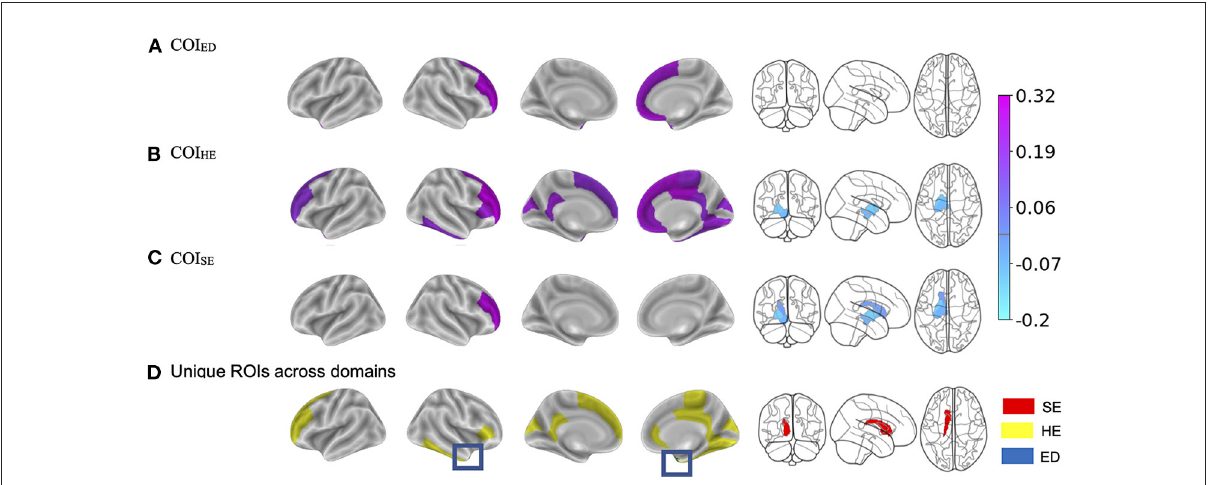
FIGURE4 (A–C) Visualization of the brain regions that showed significant two-way interactions with each Child Opportunity Index (COI) domain of interest, controlling for the other two COI domains of no interest, income-to-needs, sex, puberty, race, ethnicity, and time (e.g., visit number [baseline, year-two follow-up]). The color bar corresponds to the beta weight from the mixed models. (D) Highlights the brain regions that showed unique associations per COI model that were not associated with another COI domain. SE, social/economic; HE, health/environmental; ED, education. The blue box highlights the region that was unique to the education domain. The color bar for (A–C) , corresponds to the regression coefficients.